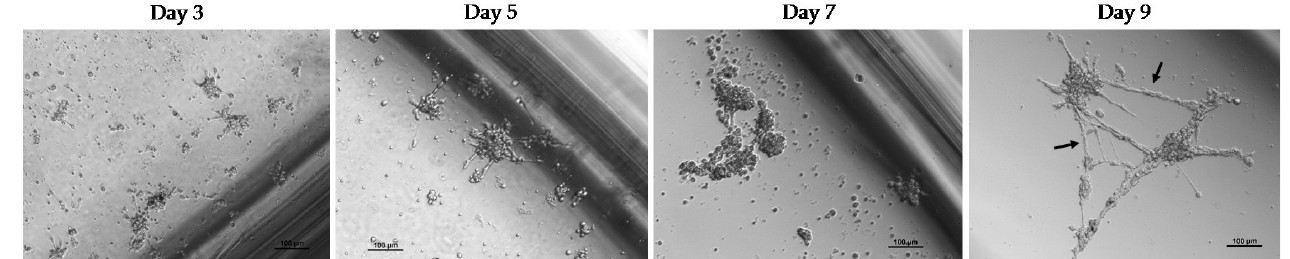
Figure 4. Follow-up of a culture of CTC spheroids derived from peripheral blood of a patient with HCC prior to TACE. CTCs were obtained by negative enrichment of CD45 − cells. Culture conditions were high glucose, normoxia, and ultra-low adherence. Images at 10 × . From patient 24 onwards, we decided to maintain cell cultures in a hypoxia incubator 224 chamber to study the effect of a deprived oxygen supply on the growth capacity of CTCs. 225 cell line. In contrast, glucose depletion negatively affected the generation and growth of 227 CSC spheroids. Thus, despite the fact that CSC spheroids are difficult to quantify and 228 measure when they are grown under ULA conditions, mainly because they usually merge 229 effects on cell growth were evident to the naked eye (Figure 5). Therefore, we concluded 231 that hypoxia for 3 days could be effective in stimulating the growth of cCSC spheroids 232 from HCC patients.